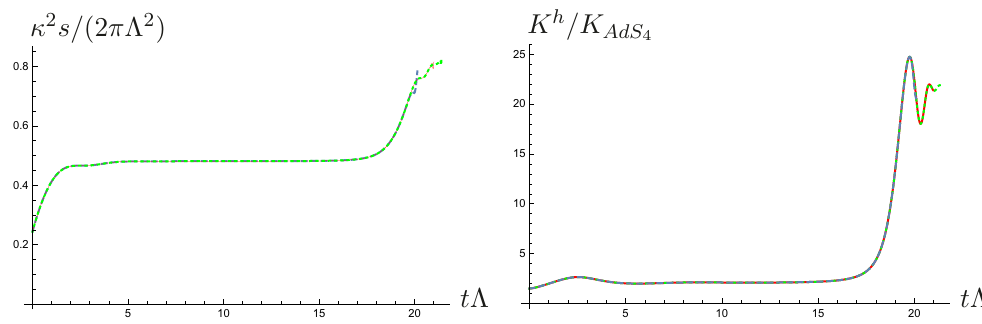
Figure 14 . Evolution of the entropy density s and the Kretschmann scalar K h evaluated at the apparent horizon in dynamics of sBBL model with g = < crit . Different color coding represents different spatial resolutions of the numerical runs. E E